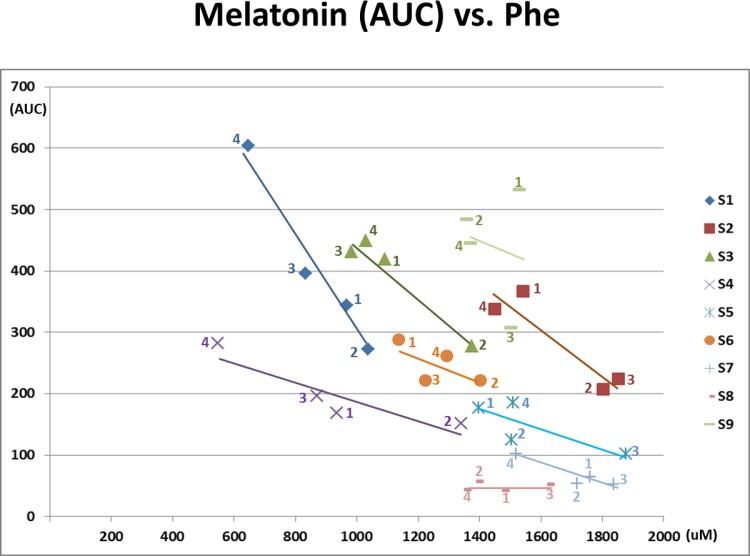
Serum Melatonin (AUC) vs. Plasma Phenylalanine.The number of each data point indicates the study phase. Negative correlations with plasma phenylalanine concentrations and serum melatonin AUC (p = 0.0005) is shown. Except for S8, a linear negative regression line is drawn for each subject. The slope of linear regression line differs among the 9 subjects (p = 0.066).